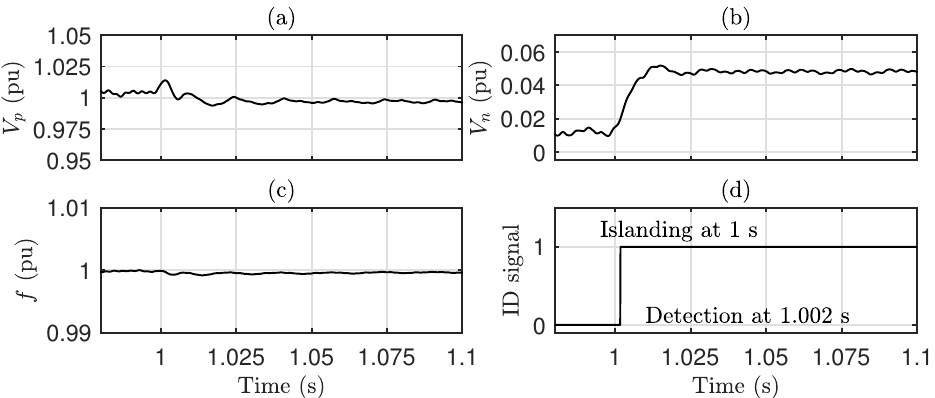
Figure 14. LCL -type filter case. Performance under weak grid condition with SCR = 1.8: ( a , b ) estimated magnitudes of positive- and negative-sequence PCC voltage, respectively; ( c ) estimated frequency; and ( d ) ID signal.